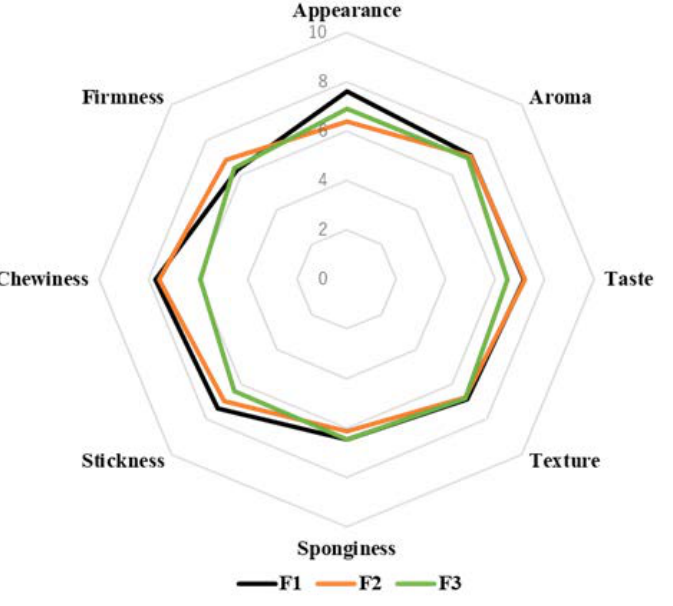
Figure 10. Sensory analysis of soy rice bread with preprocessed rice flour and/or cornstarch. Minimum score = 0 and maximum score = 10. F1: 35% replacement of soy flour (soy rice bread). F2: soy rice bread with preprocessed rice flour. F3: soy rice bread with preprocessed rice flour and cornstarch.